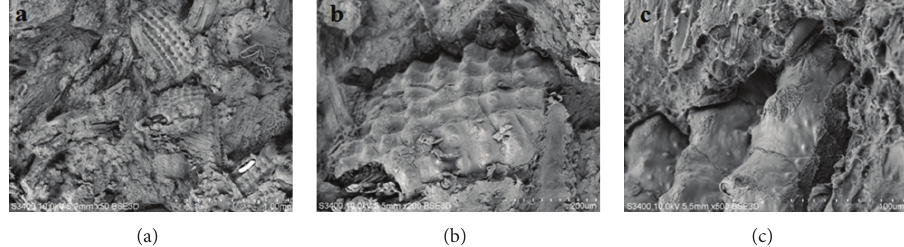
Figure 7: SEM micrograph of the surface on 40% RH loading contents composites: (a) 50x magnification, (b) 200x magnification, and (c) 500x